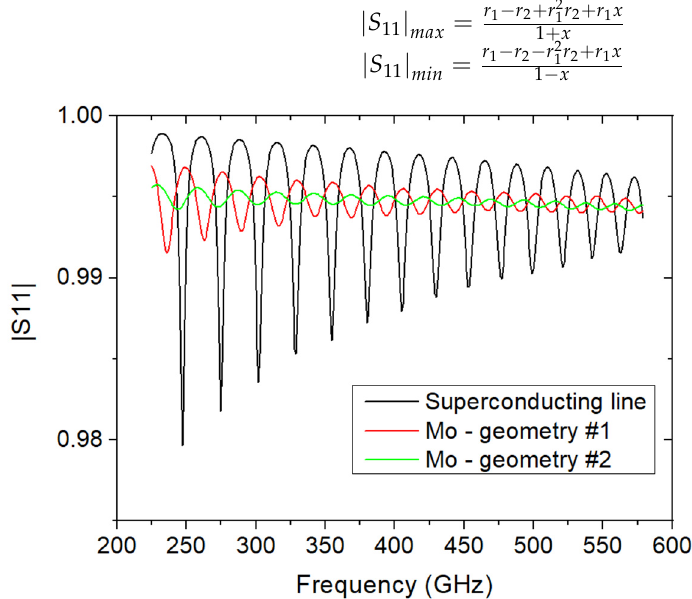
Figure 7. S 11 -parameter dependence on frequency from simulations in Ansys HFSS. Black curve represents the result for barely superconducting line; red curve depicts the geometry with normal metal in idle region, but with uncovered end; green corresponds to the geometry with normal metal both near the line and at the end (see Figure 6).